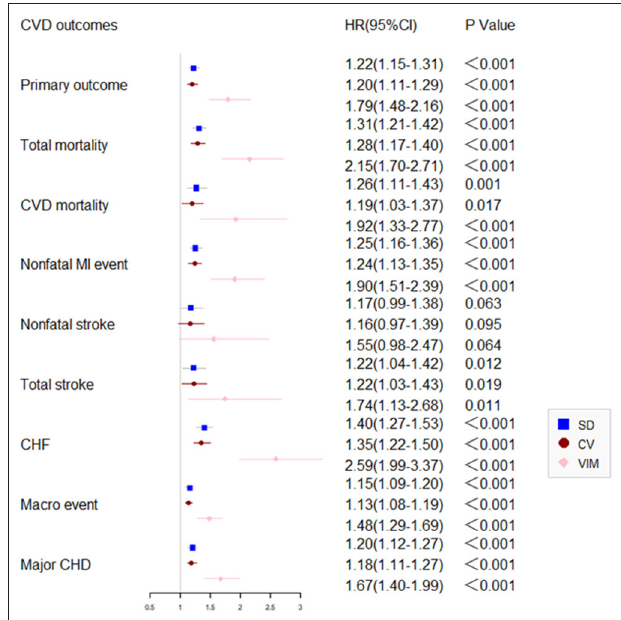
FIGURE 3 | Comparison of primary and secondary outcomes by level of HbA1c variability in the ACCORD